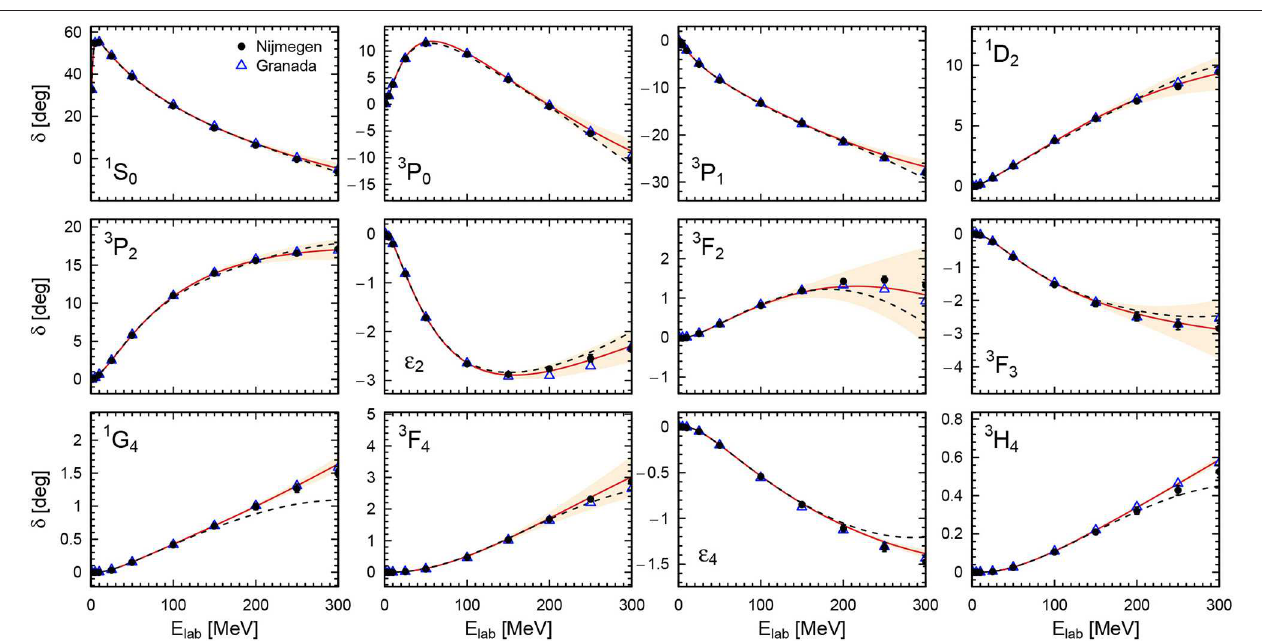
FIGURE 5 | Proton-proton phase shifts with respect to Coulomb wave functions in comparison with the Nijmegen [137] (solid dots) and the Granada [149] (blue open triangles) PWA. Red solid lines and peach-colored bands denote the central result and 68% DoB truncation errors at the order N 4 LO + for the cutoff 3 Black dashed lines denote the result of the nonlocal N 4 LO + potential of Entem et al. [ 23] for the cutoff 3 correspond to systematic errors defined in Equation (32) of Epelbaum et al. [